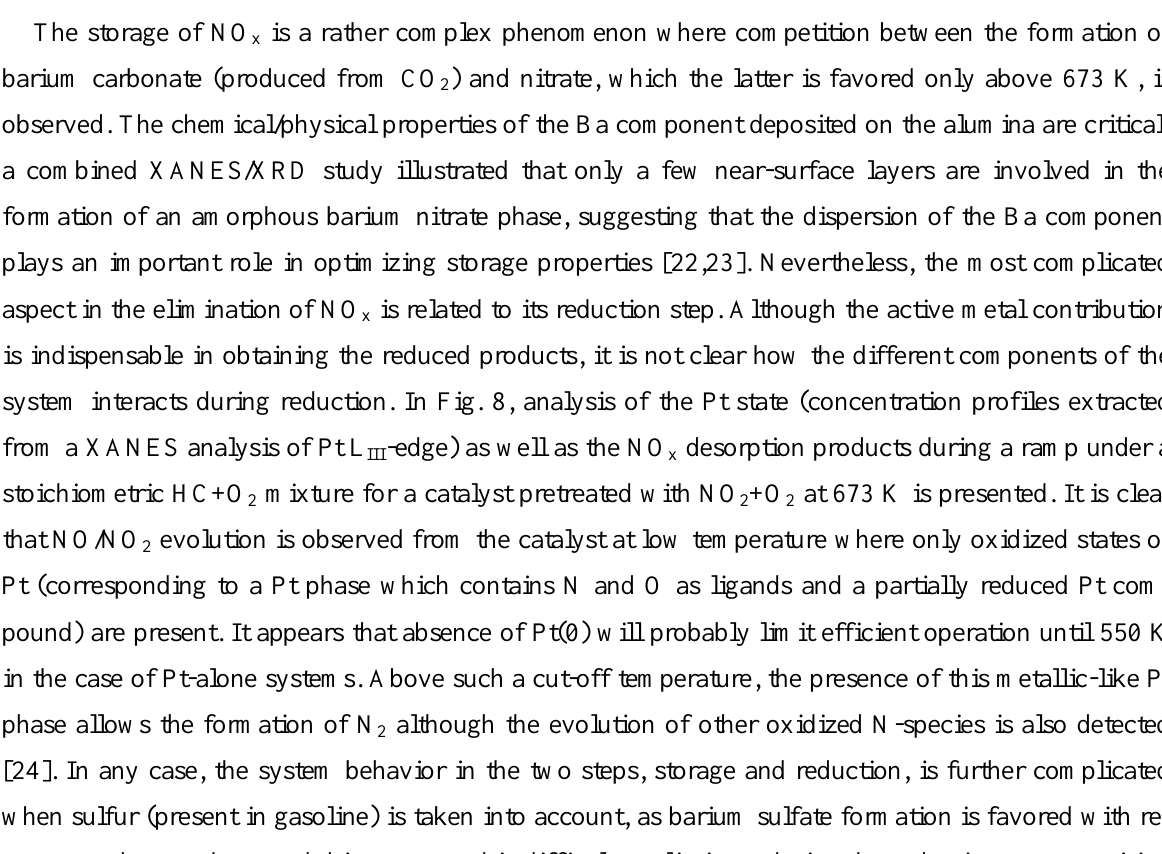
pretreated Pt/BaO/Al 2 H +O 3 6 2